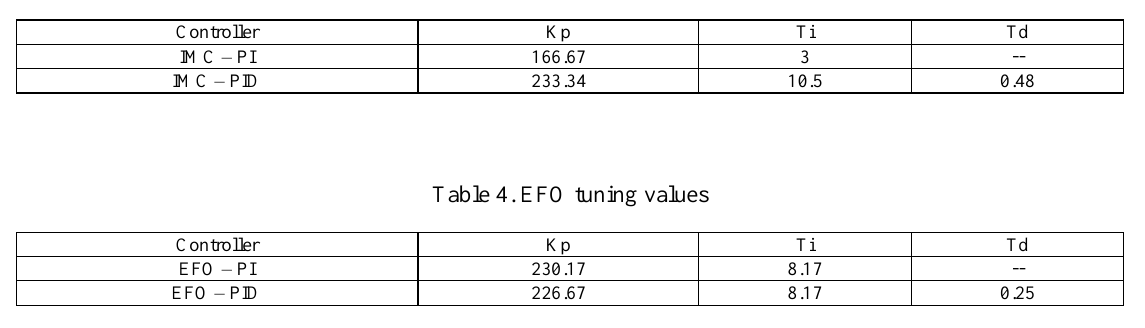
Table 3. IMC tuning values